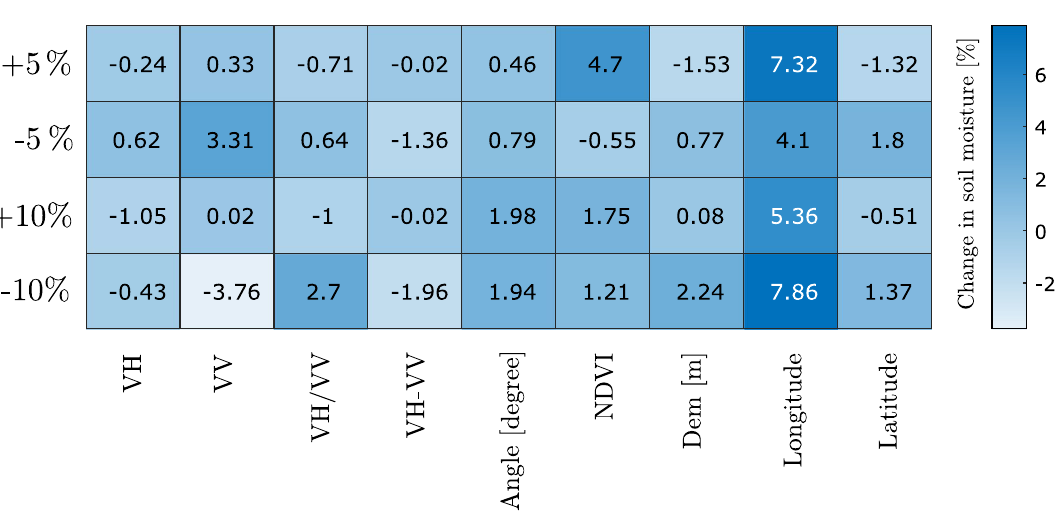
Figure 12. Sensitivity of feed-forward ANN architecture (9-5-5-5-1) by considering uncertainties ( ∓ 5% and ∓ 10%) in input